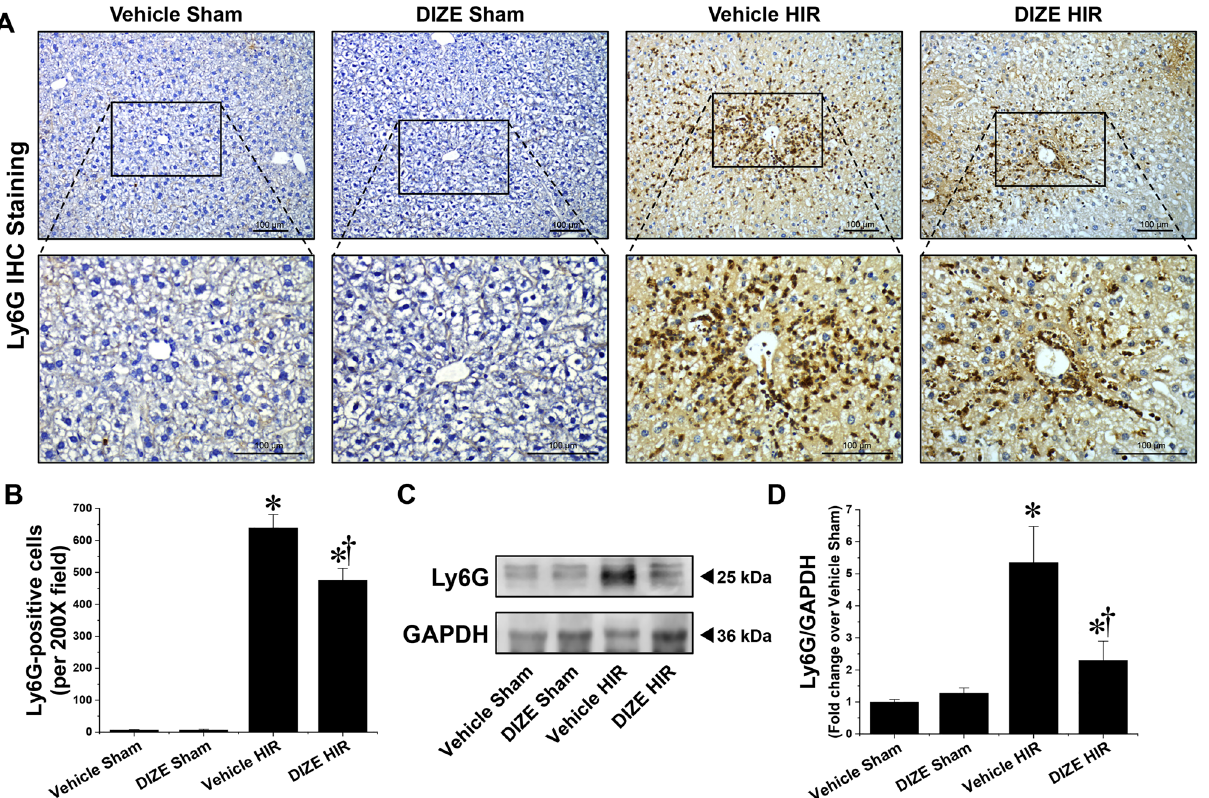
Figure 3. Effect of DIZE on neutrophil infiltration and Ly6G protein expression following hepatic ischemia/ reperfusion. C57BL/6 male mice were subjected to partial hepatic ischemia (HIR) induction for 1 h or sham surgery. Mice were treated with either Diminazene aceturate (DIZE) or vehicle control (saline) before undergoing surgery, as described in “Methods”. Twenty-four hours after surgery, liver sections were subjected to immunohistochemistry (IHC) staining using an antibody against Ly6G, a neutrophil marker ( A , Upper panel: magnification X200; lower panel: magnification X400), and Ly6G-positive cells were counted ( B ). ( C ) Whole liver lysates were subjected to western blot analysis using an anti-Ly6G antibody. GAPDH was used as a loading control. ( D ) Band intensities were measured using the ImageJ v.1.53e software. Results are expressed as mean ± SEM (n = 5). For statistical analysis, one-way ANOVA with plus Tukey’s post hoc multiple comparison test were used to detect significant changes with Origin 2021 v.9.8.0 200 (OriginLab, https:// www. origi nlab. com) software. *P < 0.05 vs. Vehicle Sham, †P < 0.05 vs. Vehicle